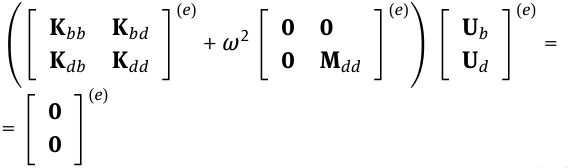
Figure 4: Outward unit normal vectors definition for a generic sub-